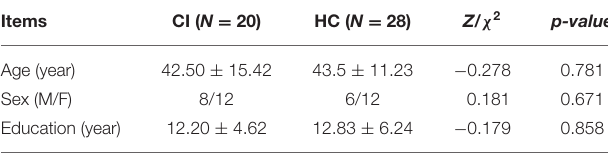
TABLE 1 | Sample characteristics of the